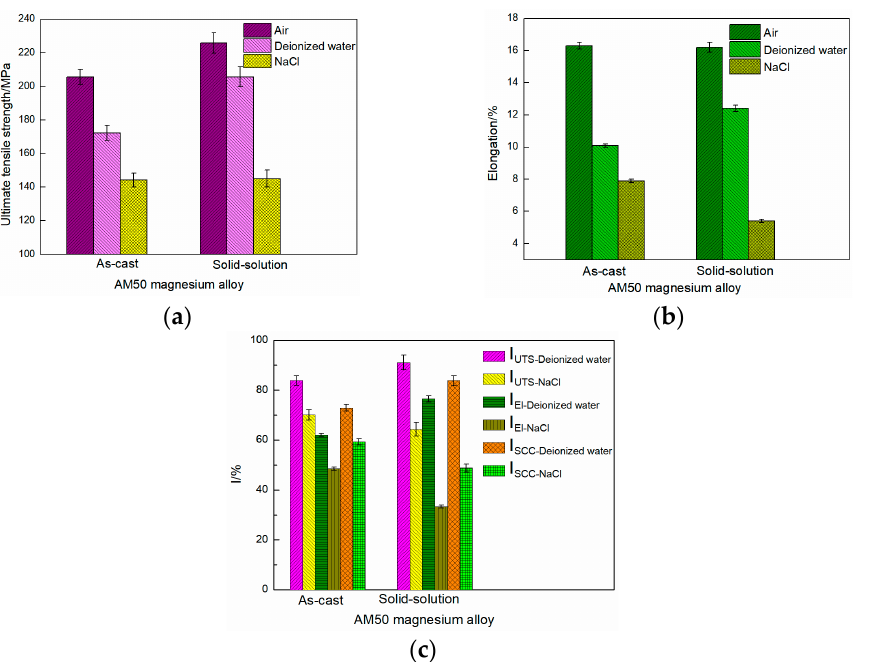
( b ) Figure 4. SSRT curves of the ( a ) as-cast and ( b ) solid-solution-treated AM50 magnesium alloy sam- ples in air, deionized water, and 3.5% NaCl aqueous solution. The UTS and El of the STSS curves before and after thermal treatment are shown in Figure 5a,b, respectively. The UTS and El of the as-cast AM50 Mg alloy were 205.6 ± 4 MPa and 16.3 ± 0.2%, and they were 223.9 ± 6.1 MPa and 16.2 ± 0.3% after solid-solution treat- ment, respectively. El did not greatly change after solution treatment, but UTS slightly